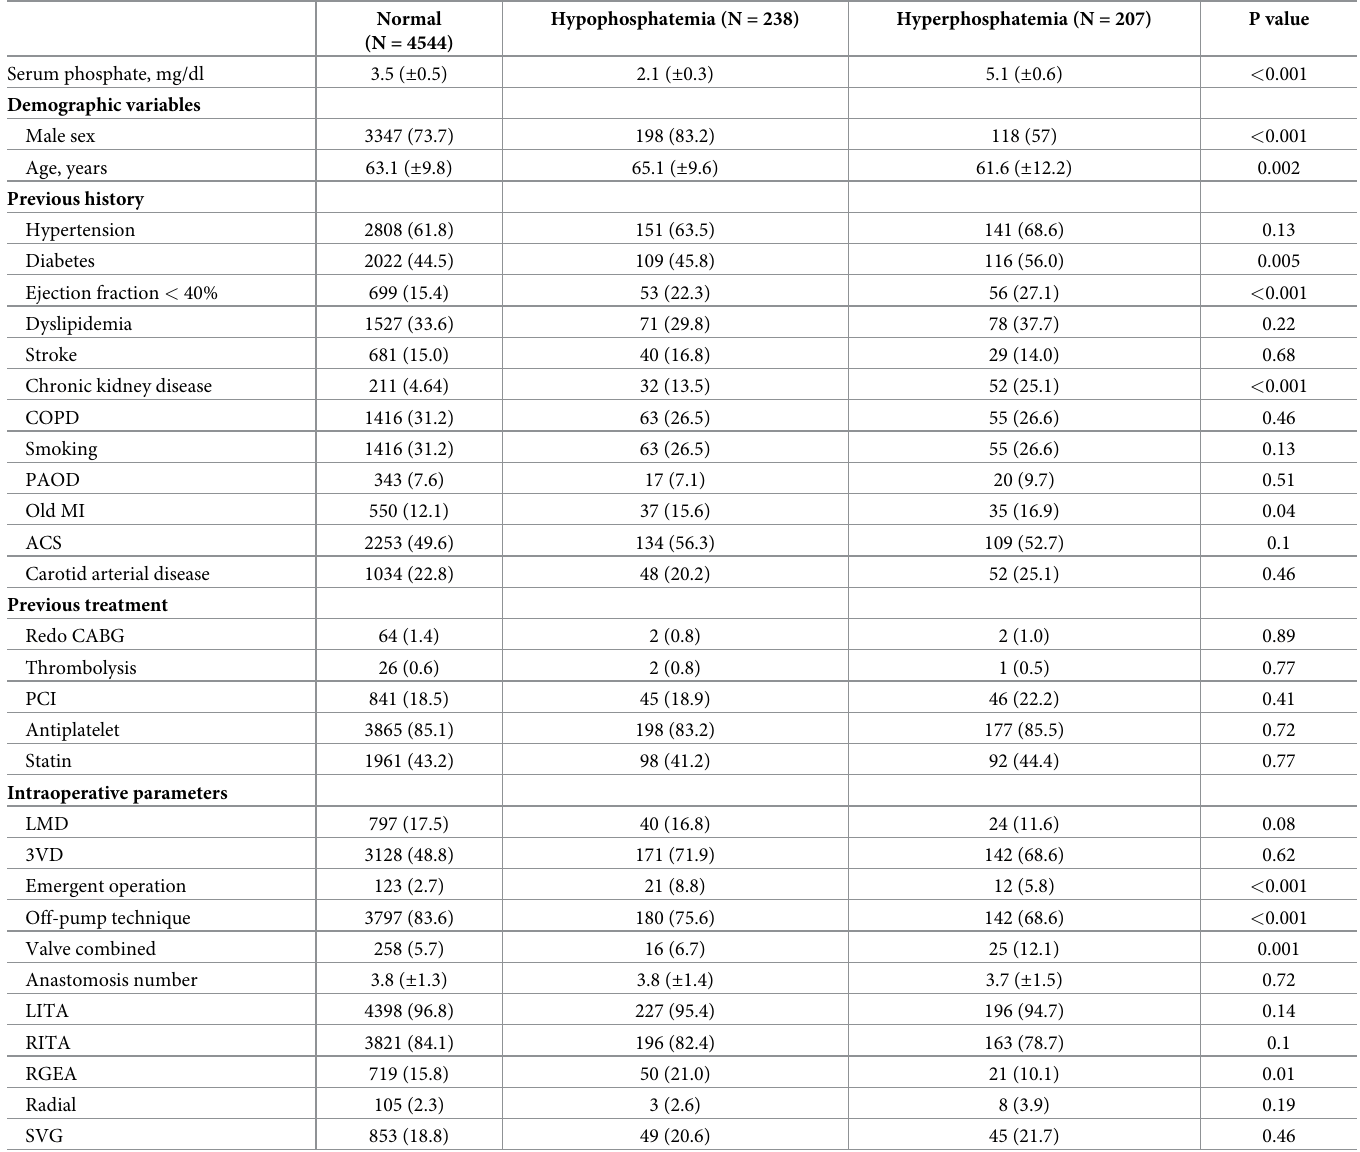
Table 1. Baseline